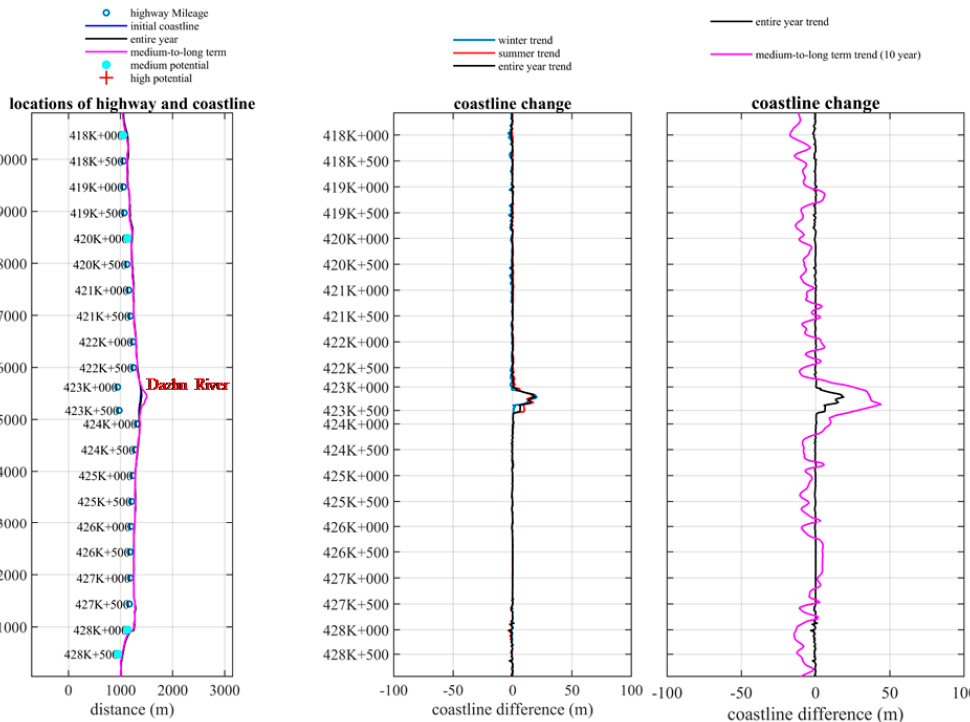
Figure 29. Map of the potential for erosion in Region B.